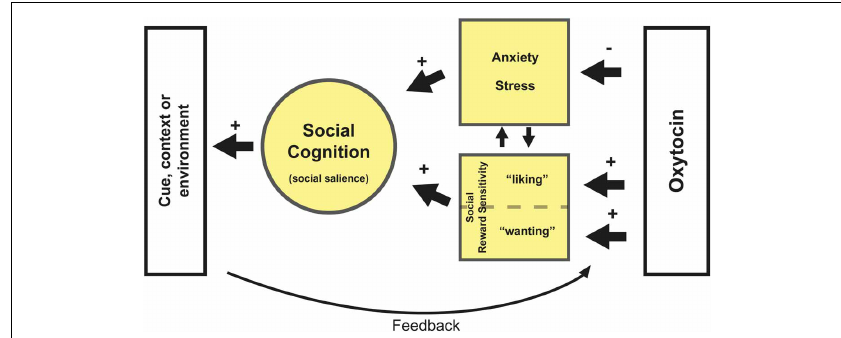
FIGURE 1 | Oxytocin reduces anxiety and stress for social interaction and increases social reward sensitivity. With respect to the latter, OXT likely affects hedonistic reward processing (e.g., “liking”) via its interaction with the opioid system and incentive reward processing (e.g., “wanting”) via a striatal-dopamine pathway (Berridge et al., 2009). Which pathway is affected likely depends on the specific context. Both reduced anxiety and increased reward sensitivity might increase sensitivity for social salience but also directly improve aspects of social cognition depending on person and context. Furthermore the subsequent contextual or environmental feedback affects the sensitivity and plasticity of the OXT system depending on its valence (e.g., positive or negative feedback). Positive feedback after OXT administration, such as pleasant social interaction, might reinforce the sensitivity for social reward and further decrease anxiety. This feedback potentially also alters the plasticity of the OXT system. For example, more OXT may be released during social interaction. Another potential scenario is that OXT administration leads to decreased anxiety, which in turn leads to heightened social salience. Which may also involve paying more attention to (potentially) negative social cues. Administration of OXT might therefore have a stronger impact on this negative feedback in neurotypical individuals, as was shown by Striepens et al. (2012). Lastly, any type of feedback resulting from altered social reward processing is likely to affect reward